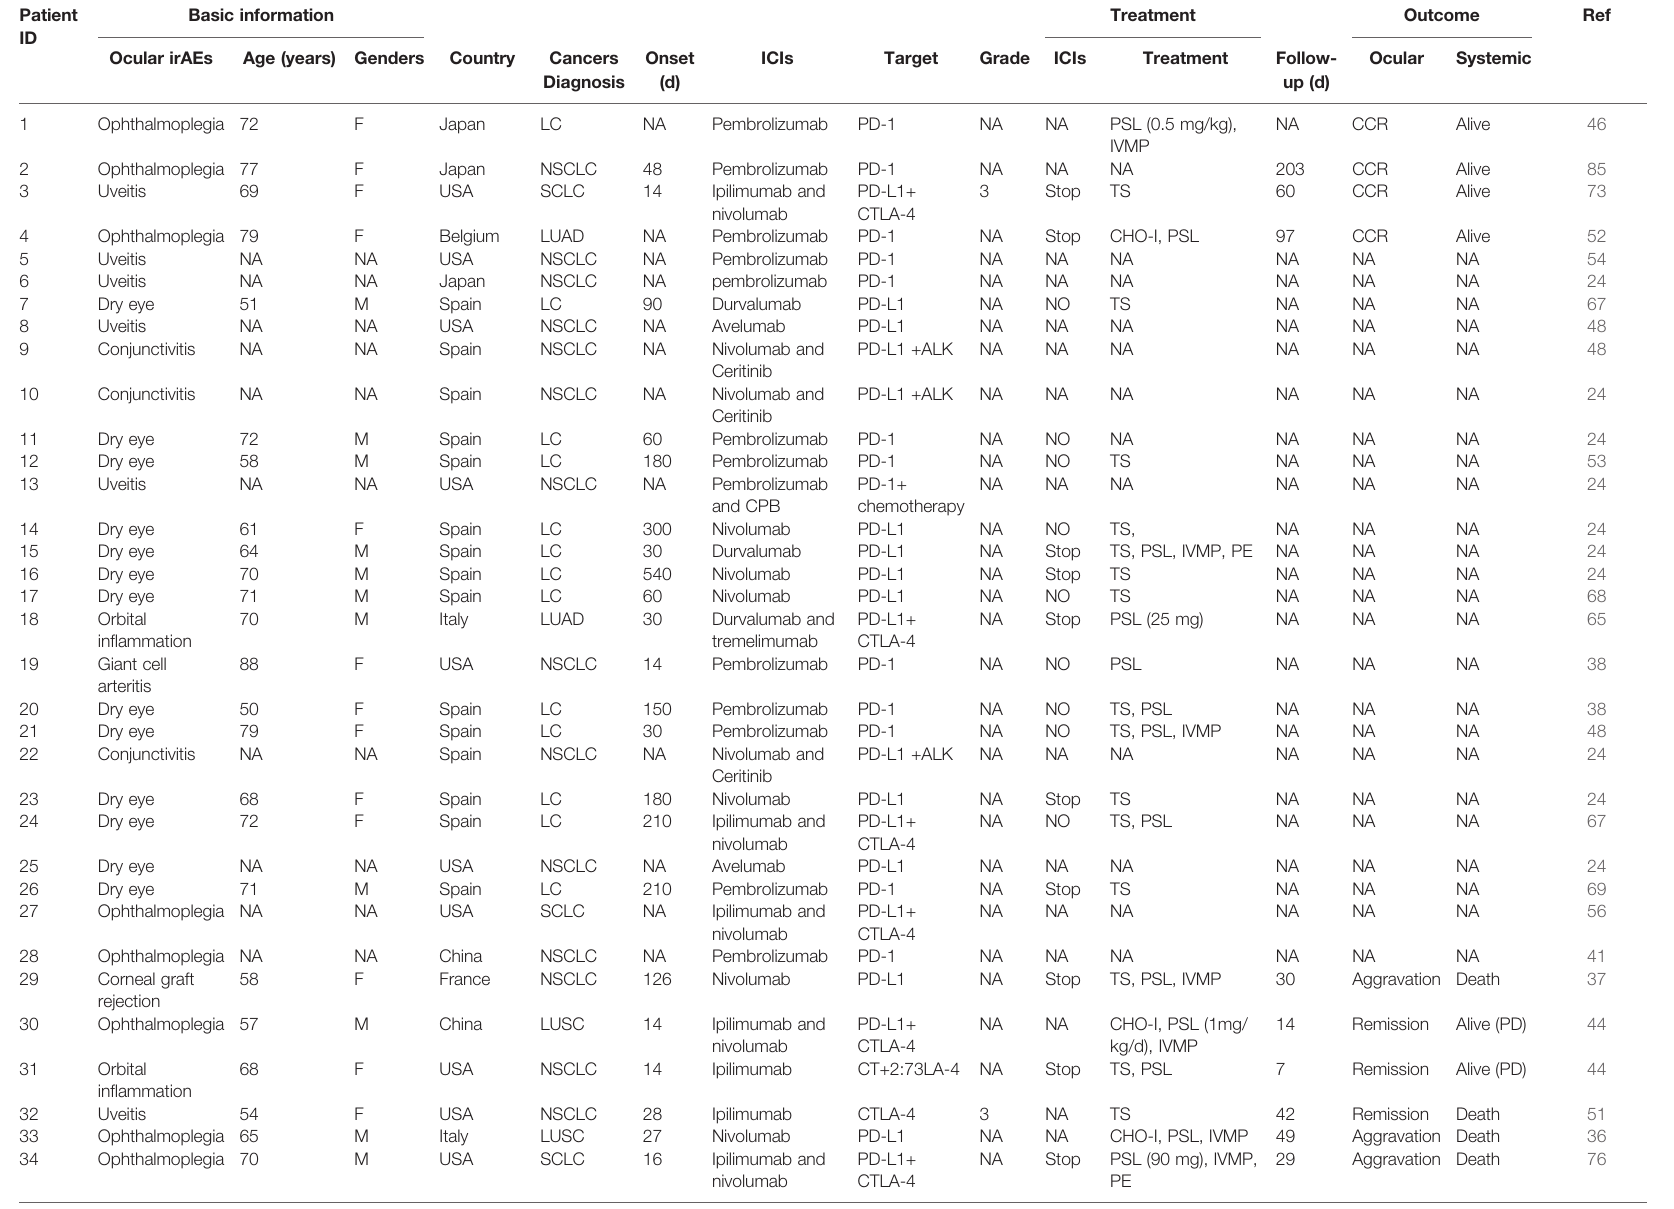
TABLE 1 | Summary of reported ocular irAEs in lung cancer treated with immune checkpoint